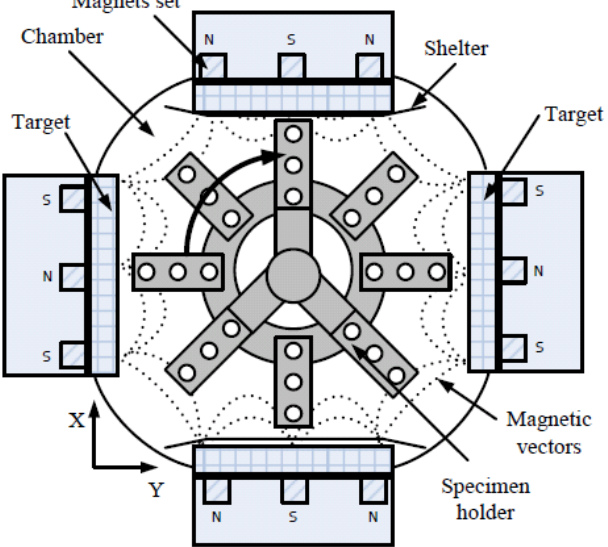
Figure 1. Schema of the closed field unbalanced magnetron reactive sputtering system.